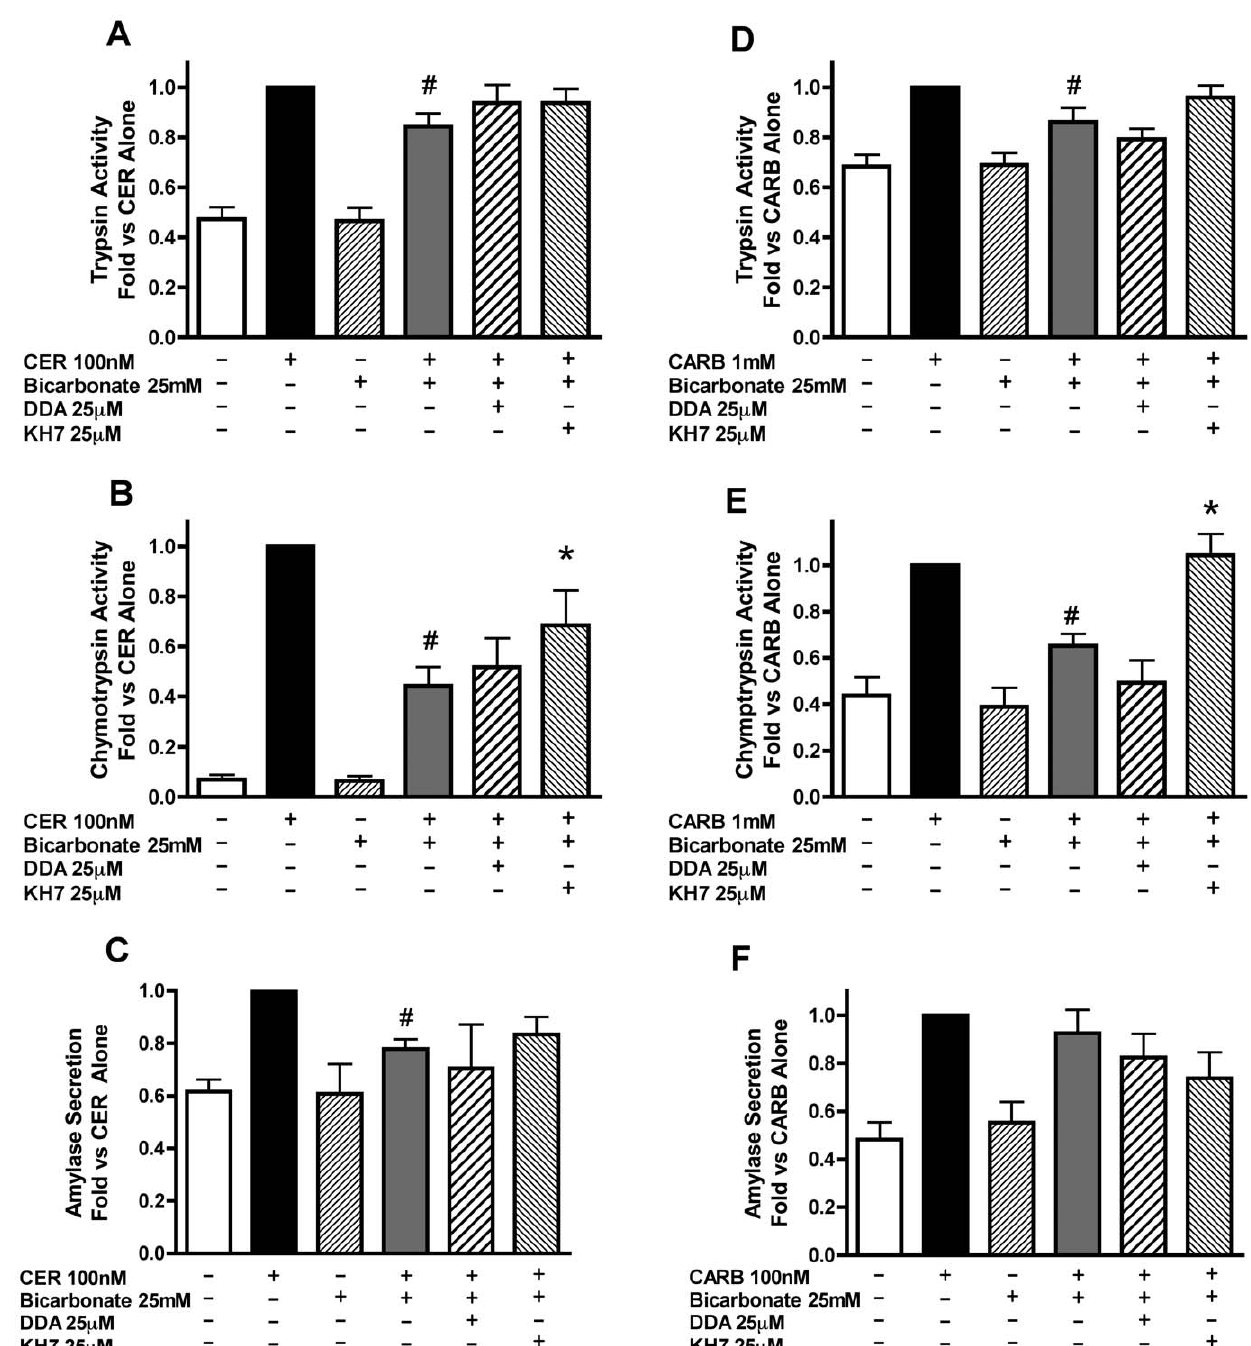
Figure 6. Activation of sAC with bicarbonate inhibits secretagogue stimulated zymogen activation and amylase secretion and is partially blocked by sAC inhibition but not tmAC inhibition. Acini were treated with or without either the sAC inhibitor KH7 [25–50 m M] for 2 hours or the tmAC inhibitor DDA [25 m M] for 1 hour prior to changing media and replacing it with either 25 mM bicarbonate at a constant flow of air/CO 2 (95/5%) or without the addition of bicarbonate under room air conditions. Secretagogue (CER 100 nM or CARB 1 mM) was added immediately after media change to the appropriate wells and acini incubated for 1 hour. Acini were collected and assayed for trypsinogen activation (A,D) and chymotrypsinogen activation (B,E) and amylase secretion (C,F). # p , 0.05 vs. corresponding treatment without bicarbonate *p , 0.05 vs. corresponding bicarbonate/secretagogue treatment (n $ 5).